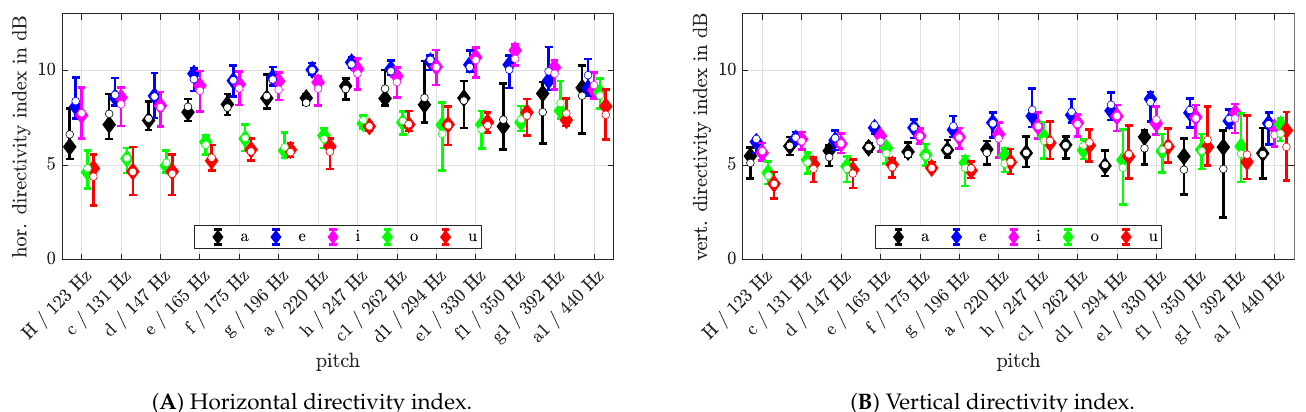
Figure 11. Means (diamonds), medians (dots), IQRs (whiskers) of the horizontal and vertical directiv- ity index in dB over pitch for the male singers for the five vowels and all phonation modes. The averaged metrics over pitch indicate a slightly trend of increased mouth openings from breathy to pressed. This is also linked to an increased effort at the vocal folds (breathy, modal, pressed) which could be noticed in the audio and during the recording session. Furthermore, the general difference between front /a:, e:, i:/ and back vowels /o:, u:/ can be made visible by the metrics. Most striking is the result for the male group of lower beam widths in the horizontal plane for the vowel /e:, i:/ indicating broader mouth openings for the male singers than the female singers. However, the generalisability of this result seems to be rather limited due to the small sample size.